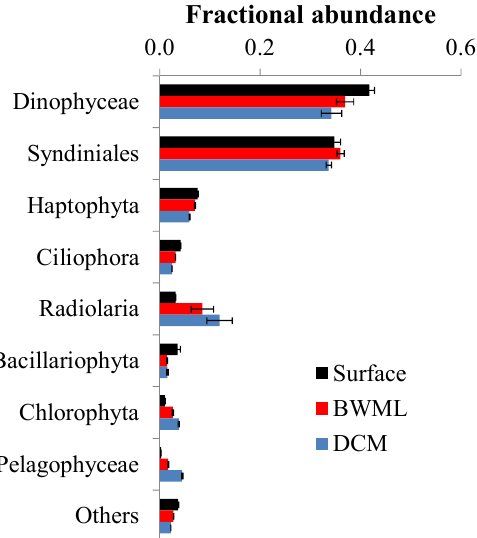
Figure 3. Average fractional abundance of the reads obtained by 18S rRNA gene sequencing of SPM from the western tropical At- lantic Ocean over the various classes of eukaryotes. The V4 frag- ment of the 18S rRNA gene was sequenced using universal eukary- otic primers. Samples were pooled according to depth and the av- erage contribution from each group at the different depth is shown. Error bars represent the standard deviation in the data from the var- ious